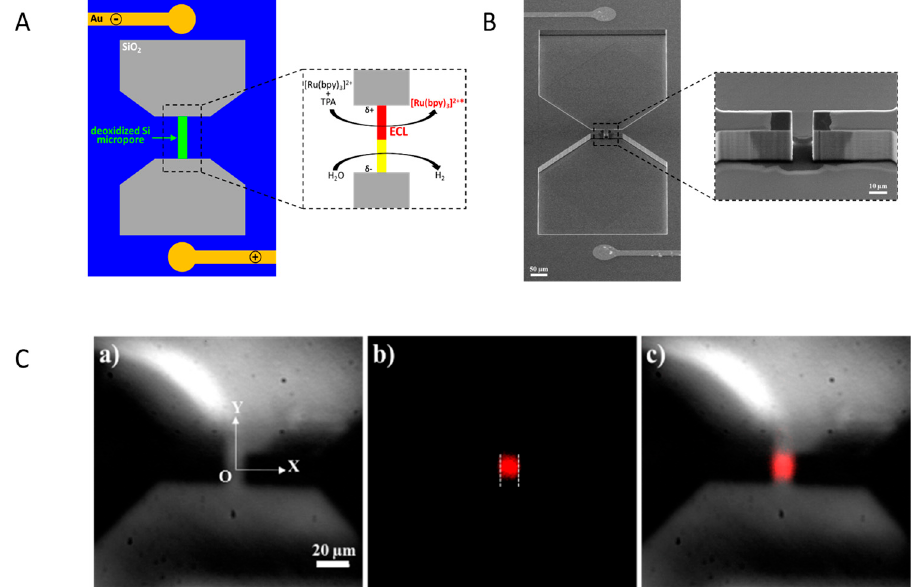
Figure 10. ( A ) Schematic principle of the silicon micropore with a deoxidized region (green) and Au feeder electrodes. Inset: simultaneous reduction of water at the cathodically polarized region (yellow) and oxidation of electrochemiluminescent (ECL) reagents at the anodically polarized region (red), leading to ECL light emission in the micropore. ( B ) SEM images of the p -doped silicon microchip with the solid-state micropore and the integrated feeder Au electrodes. The deoxidized regions appear darker around the micropore. Pore dimensions: 20 µ m (length) × 10 µ m (width) × 20 µ m (height). ( C ) Photoluminescent ( a ), ECL ( b ), and overlay ( c ) of both luminescence images of the same region of interest around the micropore. Both axes are represented and the origin, O, of the axes is defined as the center of the micropore. The dashed lines materialize the micropore walls.